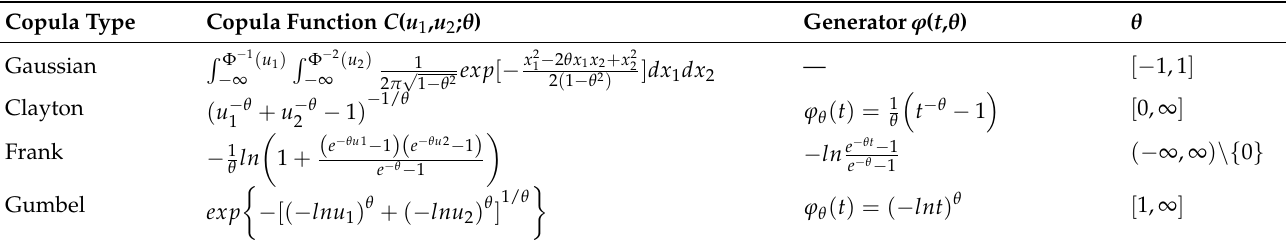
Table 3. Selected Archimedean copulas for